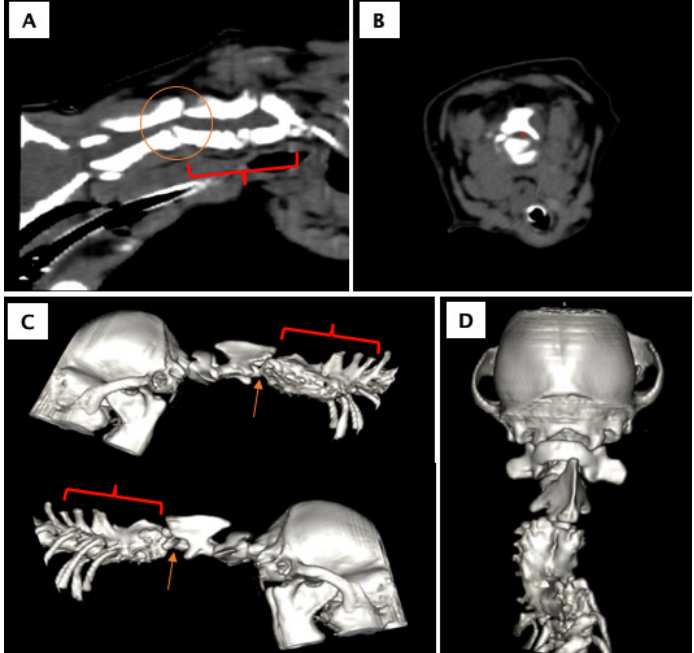
Figure 3. CT images and 3D reconstructions of the cranio-cervico-thoracic region of a 3-month-old male MBD dog, with congenital vertebral malformations. (Veterinary Hospital/UFRRJ – August/2019) Note. A) CT image of the cranio-cervico-thoracic region, with helical acquisition and 2.0 mm cross-section, showing an important dorsal deviation of the bone axis between the C2 and C3 vertebrae (orange circle), resulting in canal stenosis and marked spinal cord and marked spinal cord compression (red asterisk). C) 3D reconstruction of the lateral cranio-cervico-thoracic region (top image – left view/ botton image – right view), showing shortening and remodeling of the vertebral bodies from C3 to T3 (block formation) (red bracket) and its dorsal deviation in relation to the C2 vertebra (orange arrow). D) 3D reconstruction of the dorsal cranio-cervico-thoracic region showing spinal block formation of C3-T3 and